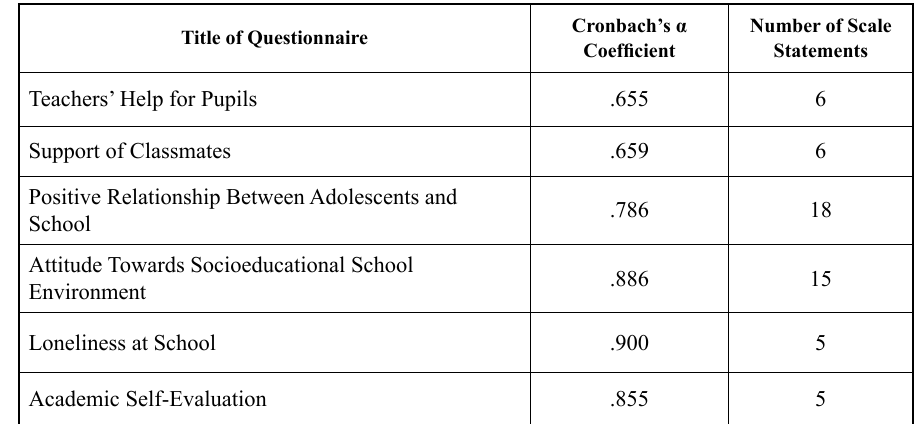
Table 1. Internal coherence indices of